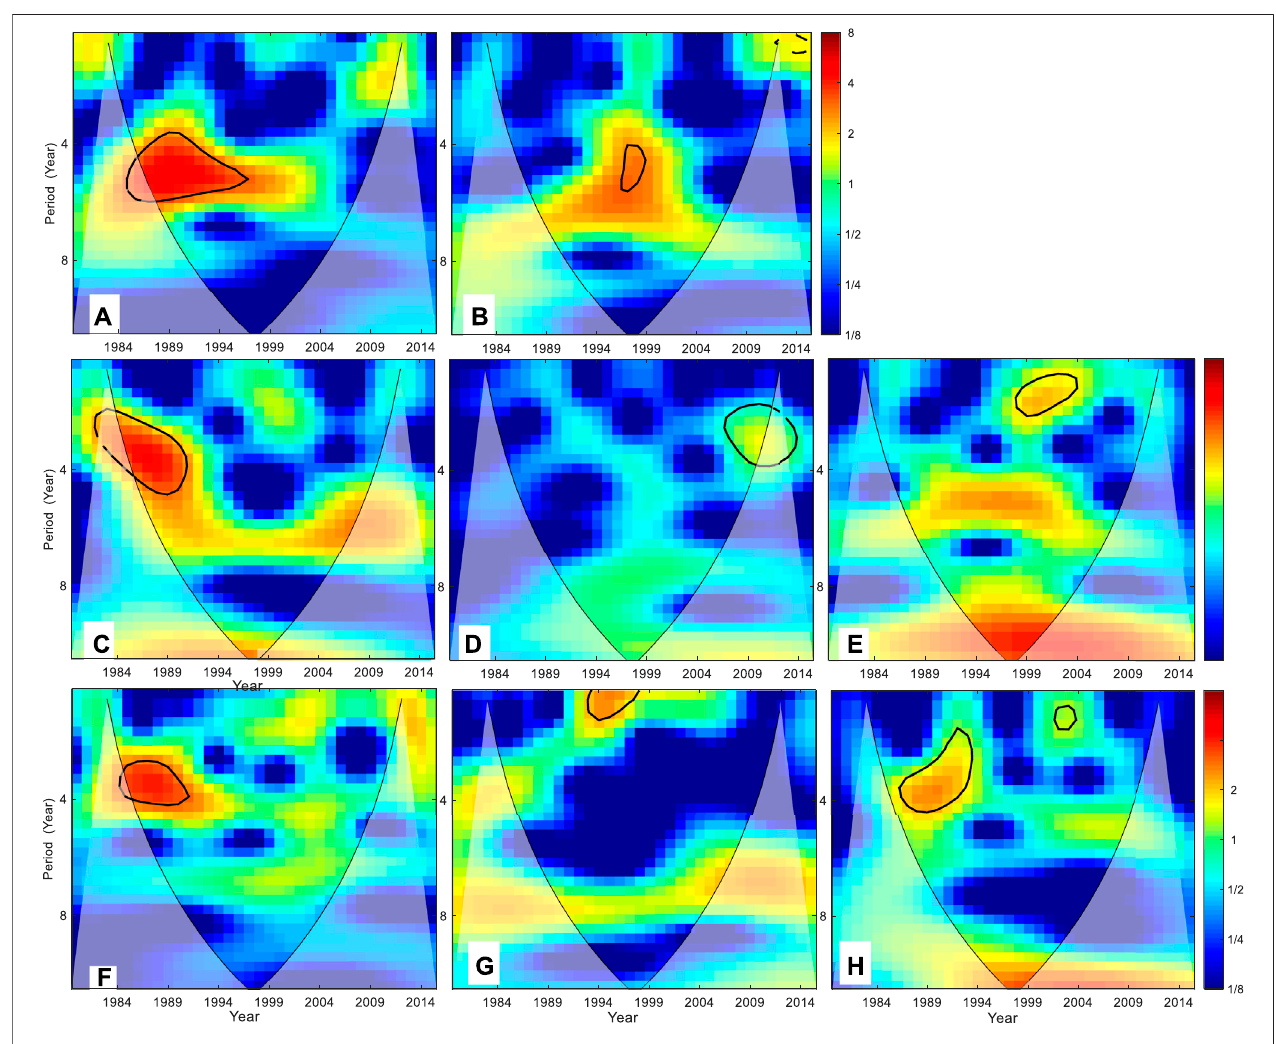
FIGURE13 | Waveletanalysisofthe WPD inthe tropical Indian Ocean (A) ,extratropical south Indian (B) , extratropicalNorth Paci fi c (C) , tropical Paci fi cOcean (D) , extratropical South Paci fi c (E) , extratropical North Atlantic (F) , tropical Atlantic Ocean (G) , and extratropical South Atlantic (H) .